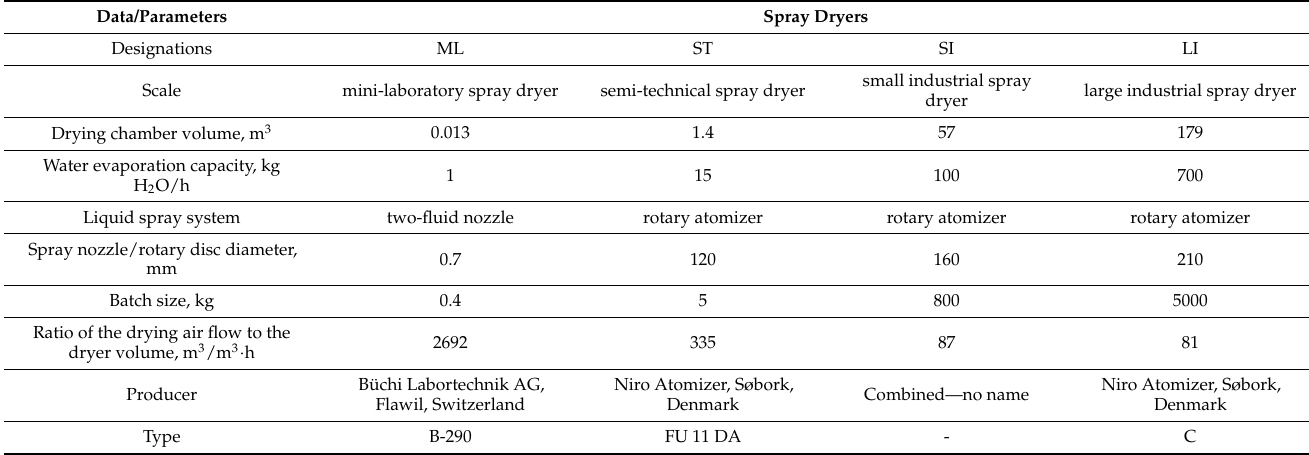
Table 4. Designations and data of spray dryers